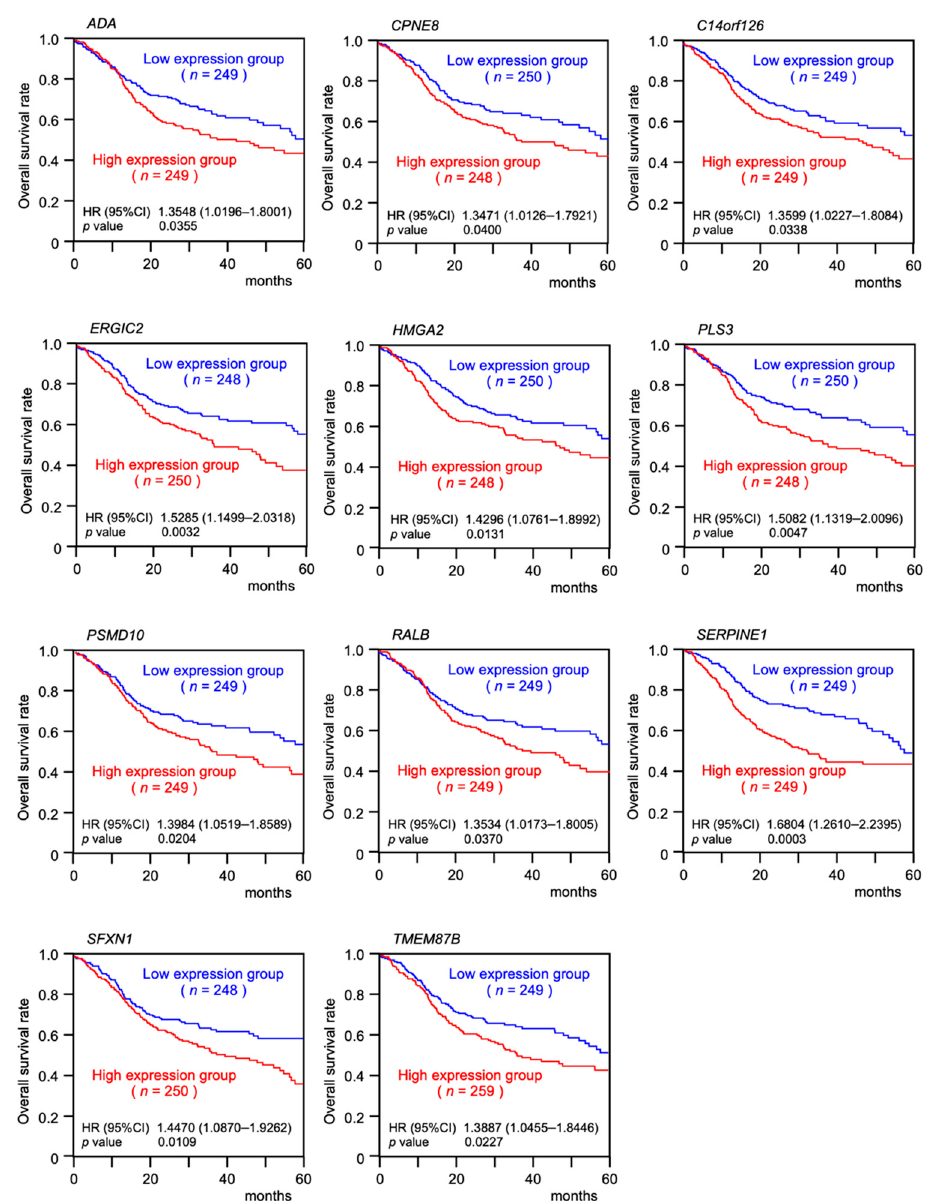
Figure 4. Five-year survival rates of 11 target genes of miR-30e-3p using TCGA-HNSC data. Kaplan– Meier survival analyses of HNSCC patients using data from the TCGA database. Patients were divided into high and low expression groups according to the median of each gene expression level. The red and blue lines indicate the high and low expression groups, respectively.